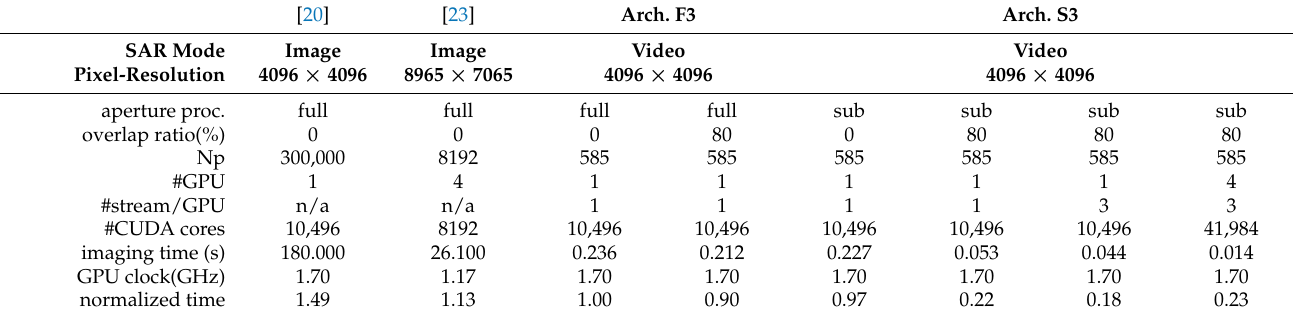
Table 9. Performance comparison with previous